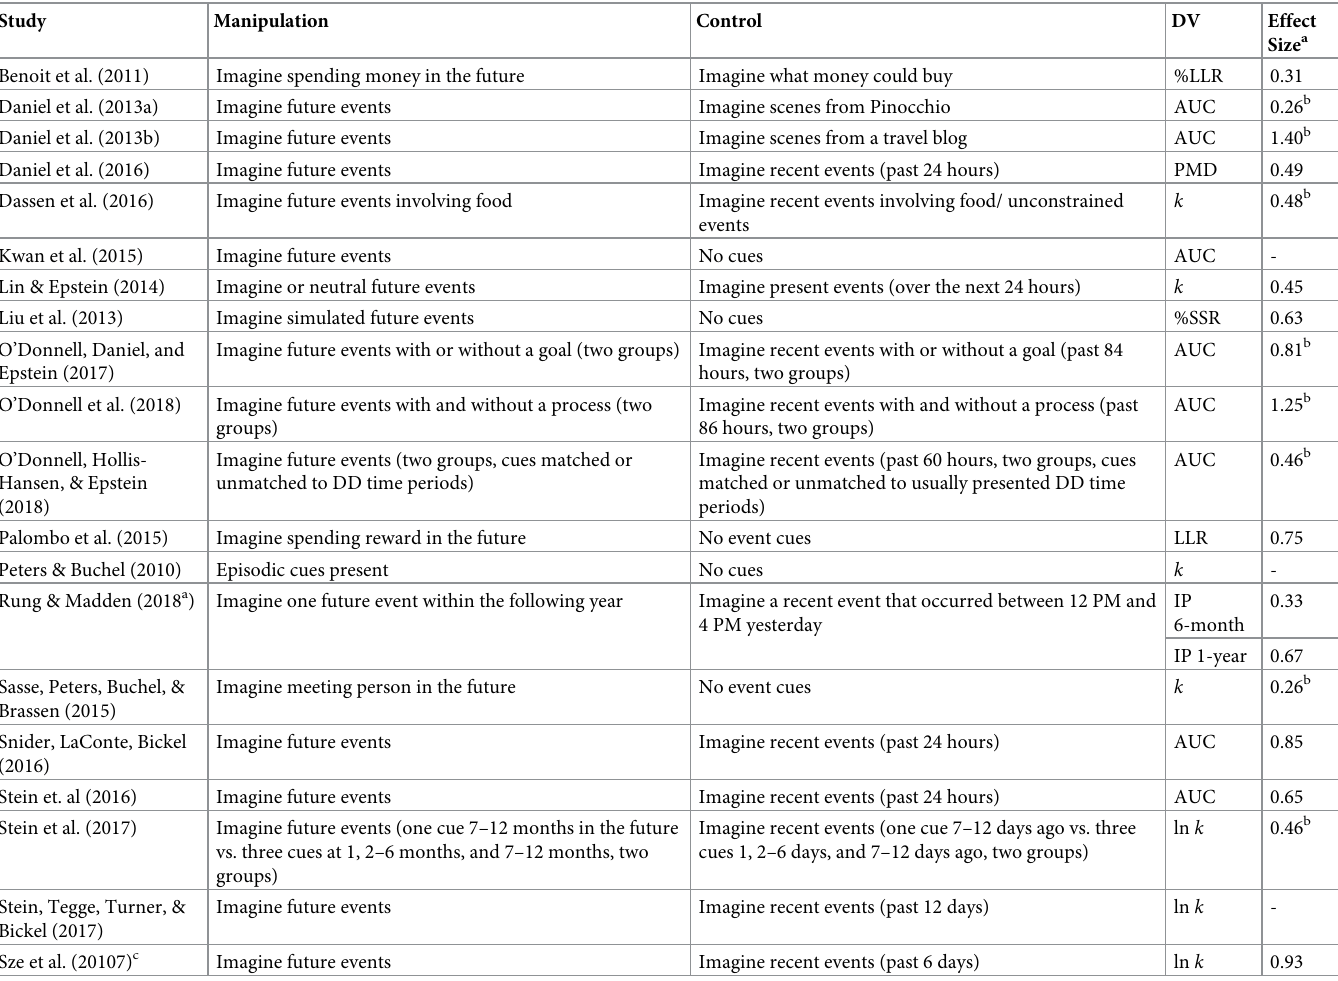
Table 1. Control groups in prior episodic future thinking (EFT)